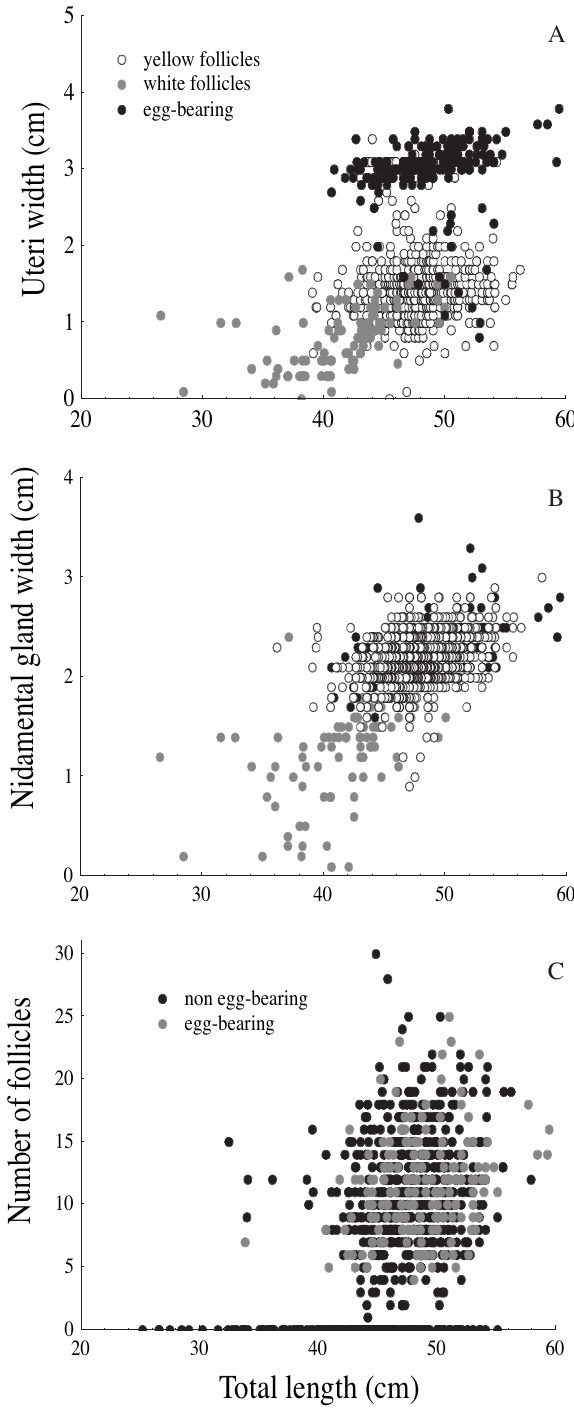
F IG . 4. – Rioraja agassizi. Relationship between total length (cm) and (A) uteri width (cm), (B) nidamental gland width (cm), and (C) number of mature follicles and total length